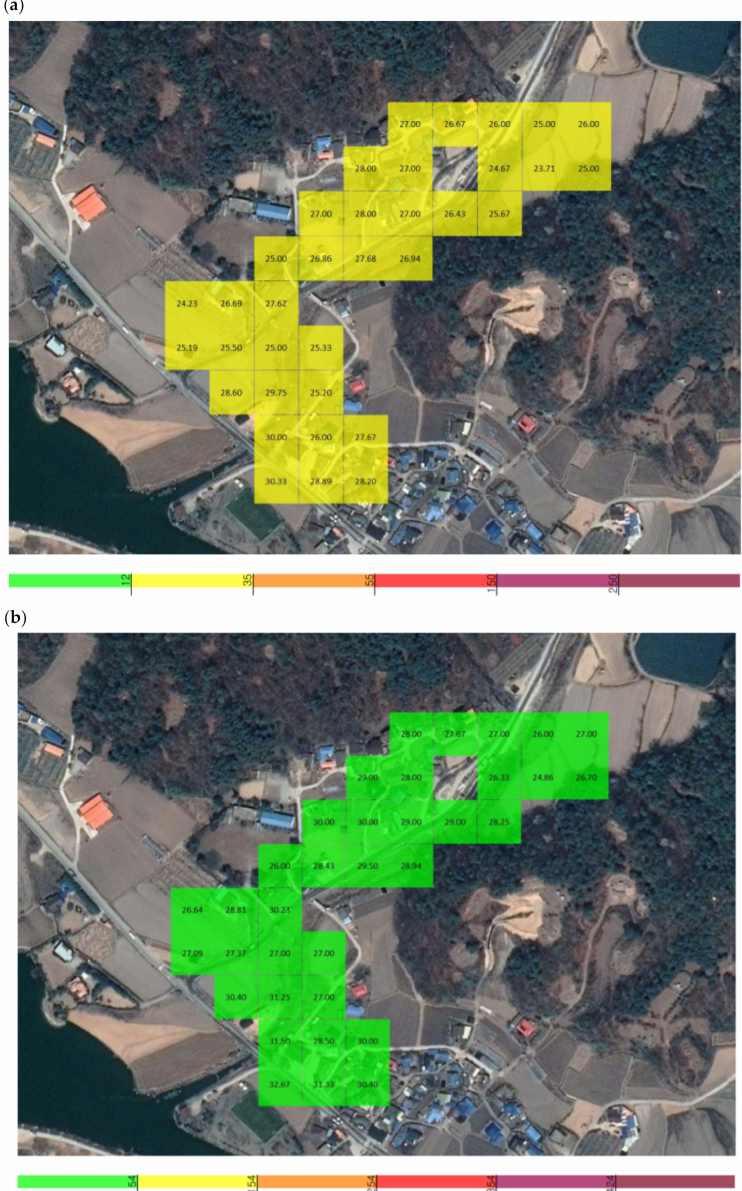
Figure 9. Grid detection area of the UAV measuring sensor in the area nearby Y quarry: ( a ) PM 2.5 , ( b ) PM 10